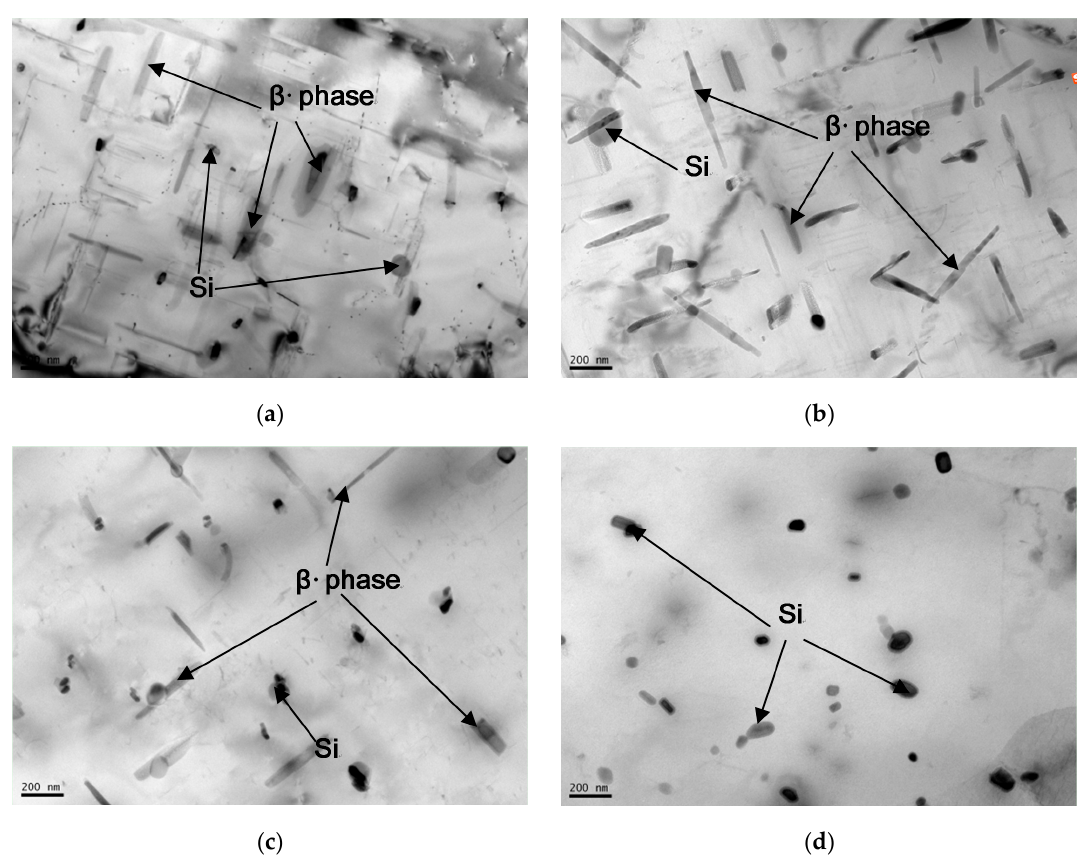
Figure 3. The TEM observations for di ff erent characteristic area showing the precipitates and second phase: ( a ) BM; ( b ) HAZ; ( c ) TMAZ; ( d )